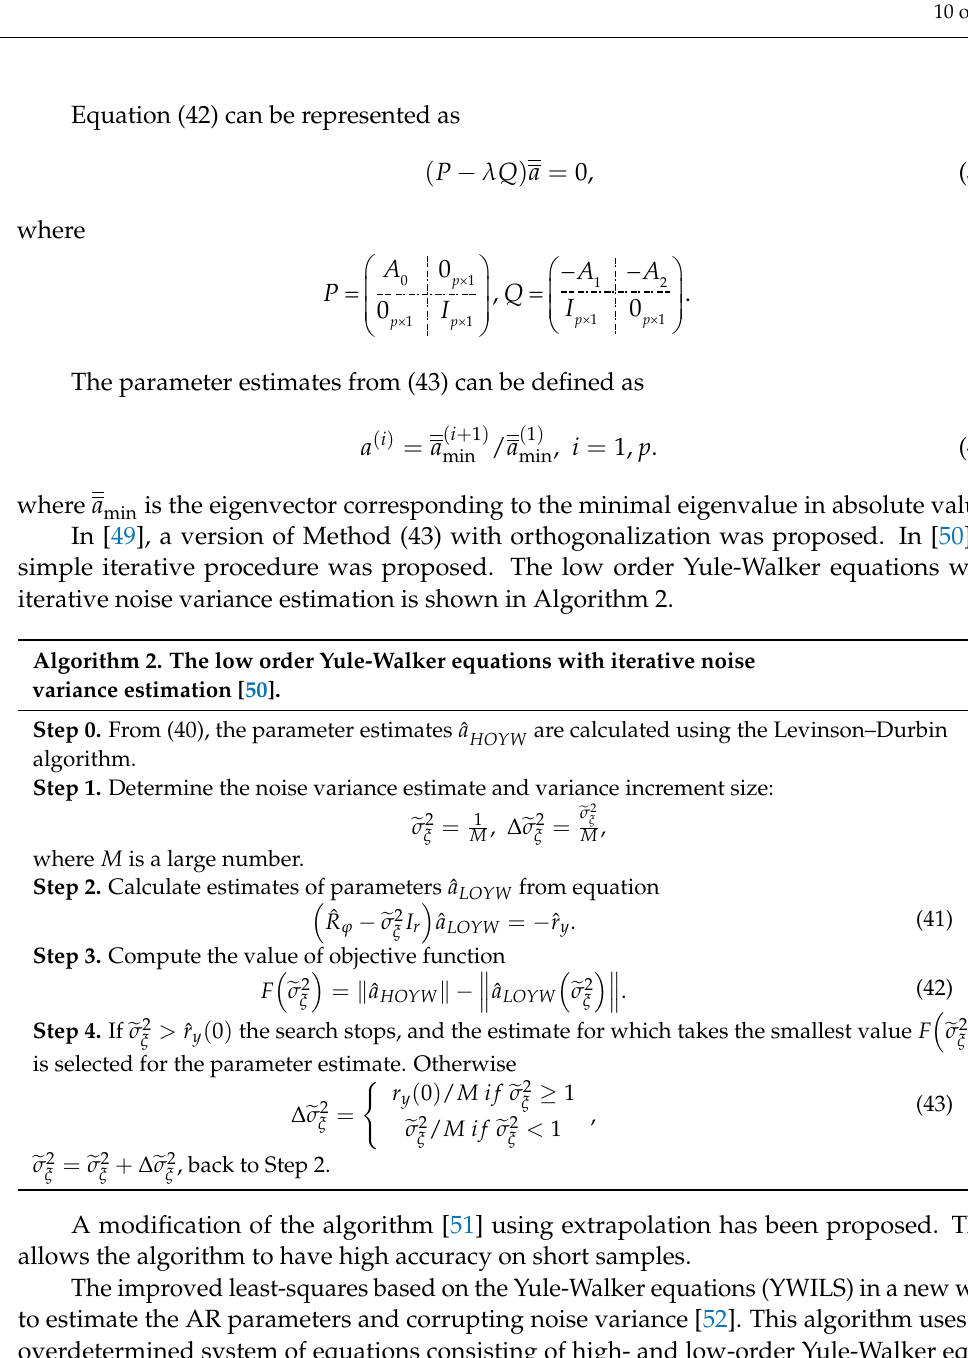
Algorithm 3 [52]. Improved least-squares based on the Yule-Walker equations